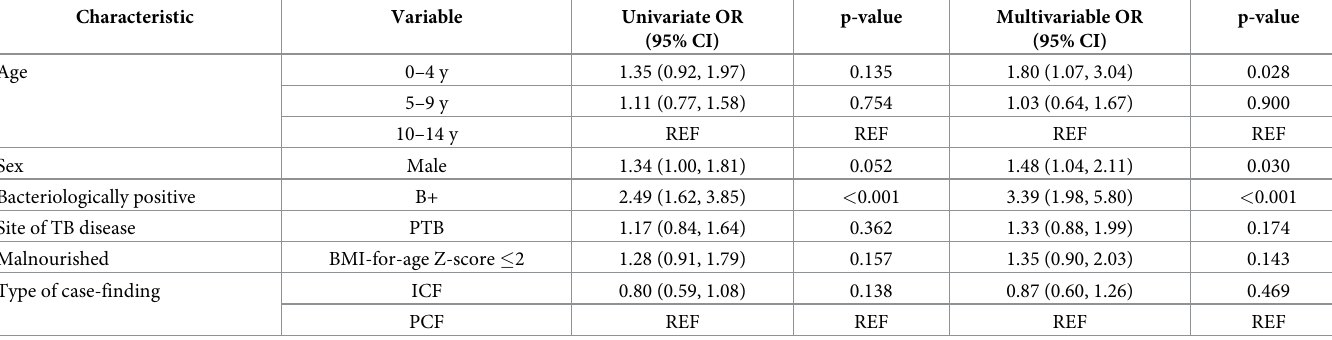
Table 3. Univariate and multivariable associations of child characteristics and unsuccessful treatment